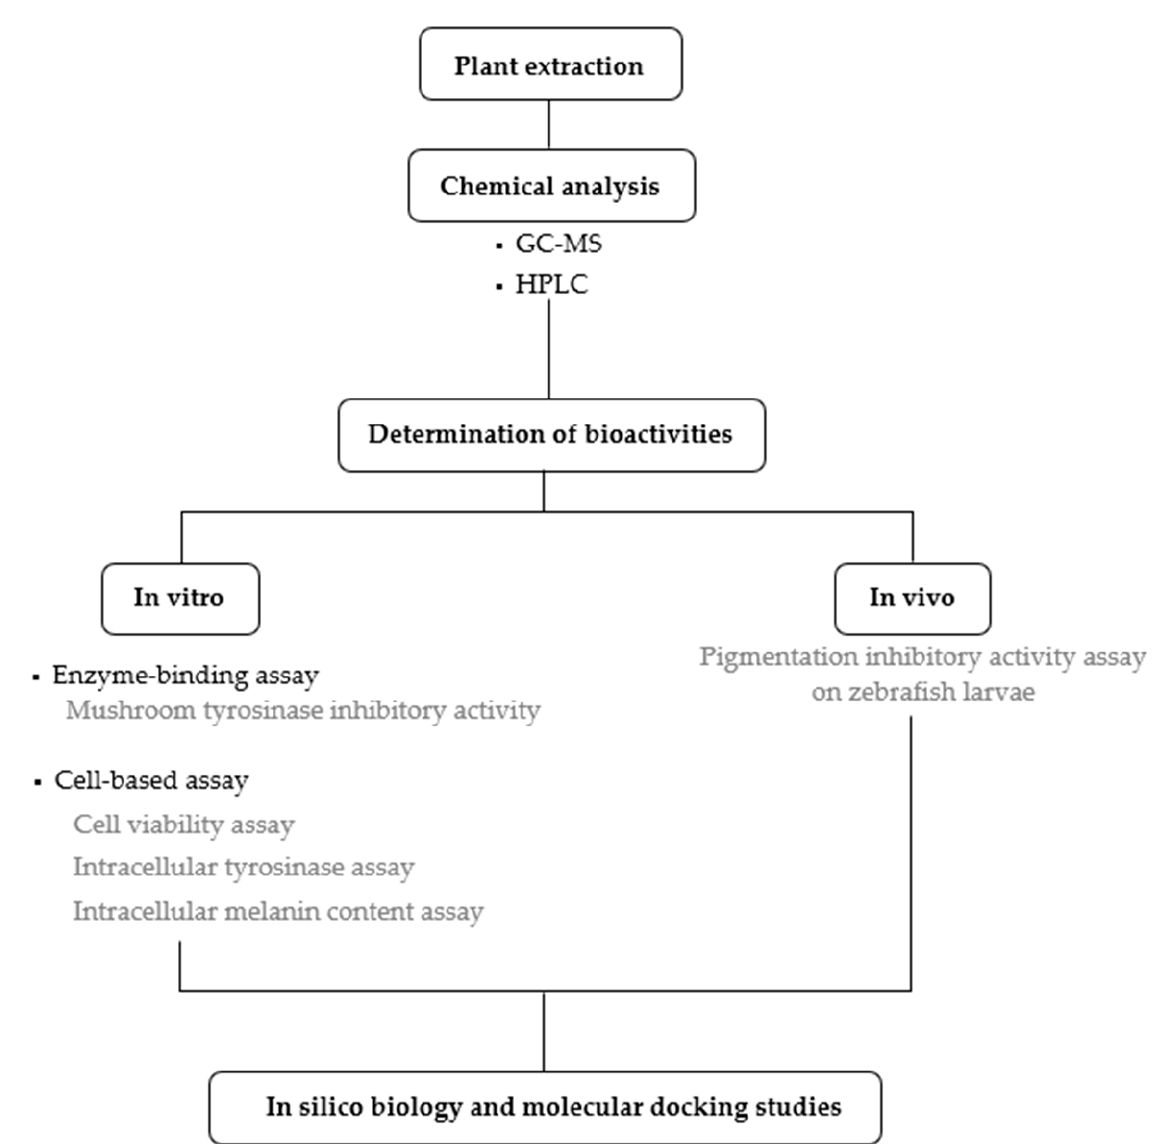
Figure S4: Docking validation protocol for tyrosinase; Figure S5: 2D molecular interaction be- tween glabridin and tyrosinases from mushroom, murine, and zebrafish; Figure S6: Overlaying docking results of glabridin and its derivatives on mushroom tyrosinase; Figure S7: Overlaying docking results of glabridin and its derivatives on murine tyrosinase; Figure S8: Overlaying docking results of glabridin and its derivatives on zebrafish tyrosinase; Figure S9: Protein structural align- ment between human and zebrafish MC1R; Figure S10: Docking validation protocol for zebrafish MC1R; Figure S11: Combining docking results between zebrafish MC1R and glabridin derivatives; Figure S12: Combining docking results between zebra fi sh MC1R and ethyl- p -methoxycinnamate derivatives; Table S1: Anti-mushroom tyrosinase screening of sixty- two Thai rejuvenating remedies; Table S2: Intercellular melanin content of B16F1 cells treated with α -MSH, positive controls (arbutin, kojic acid, and A. lacucha wood, water extract), and test samples (crude, hexane, ethyl acetate, and ethanol extracts of the selected remedy); Table S3: Cell viability test of arbutin up to 200 µg/mL concentration; Table S4: Anti-zebra fi sh pigmentation of all samples; Table S5: Accession numbers of all tyrosinase amino acid sequences used in this study; Table S6: Chemical list in the PubChem database. Author Contributions: Conceptualization and supervision, S.D.-a.; methodology, S.D.-a., N.K., W.N., T.H.K., and T.P.; investigation, N.K., W.N., and T.P.; writing-original draft preparation, N.K., T.P., and S.D.-a.; writing—review and editing, S.D.-a. and T.P.; co-supervision, C.W.; funding ac- quisition, S.D.-a. All authors have read and agreed to the published version of the manuscript. Funding: This research was funded by grant No. PHA6404130S from the Faculty of Pharmaceutical Sciences, Prince of Songkla University, the Discipline of Excellence in Pharmacy and the Faculty of Pharmaceutical Sciences Dissertation Funding for Theses through the Faculty of Pharmaceutical